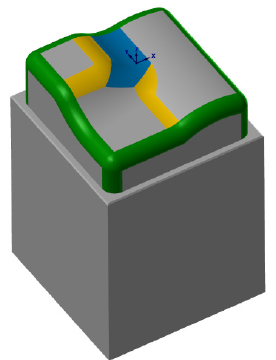
Figure 5. CAD geometry used in experiments (Surfaces: R2 mm—green, R5 mm—yellow, R6 mm—blue).